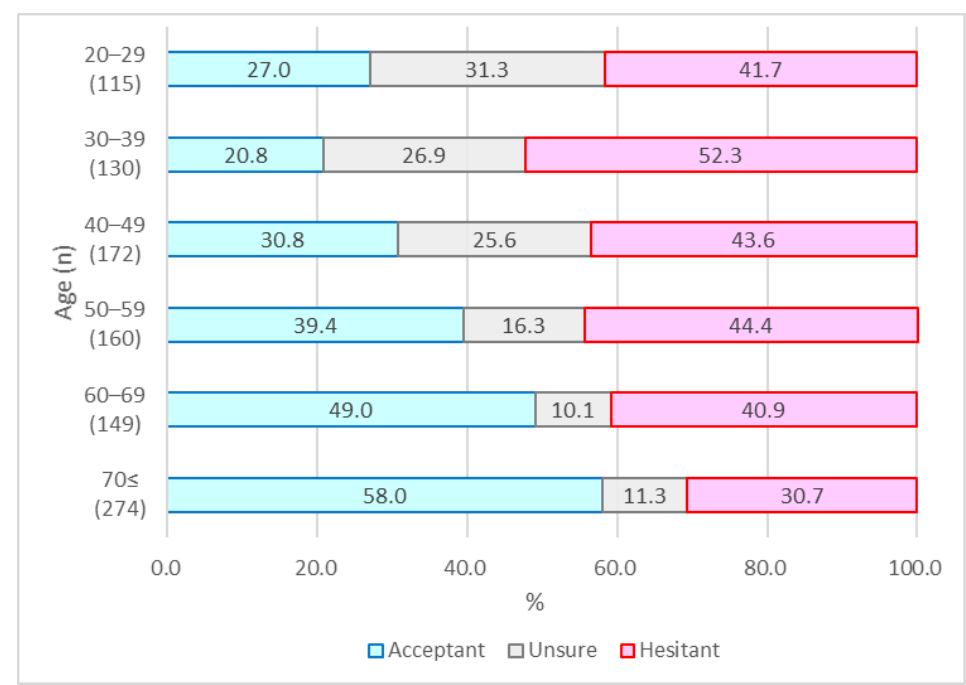
Figure 1. Vaccination attitude by age group in April 2021.